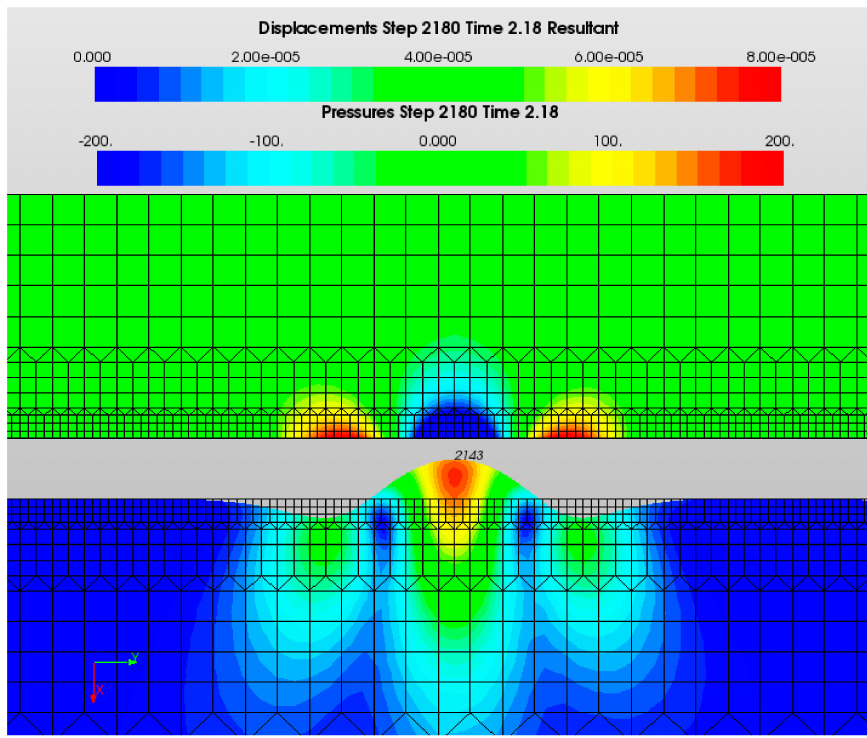
Figure 2. This display shows the region around node 2143, an element junction at 217 m radius from the model centre to the left. Results for the solid displacements are vector magnitudes, colour coded up to 80 µ m, using a similar colour display used in Figure 1, where blue shows a low value. The deformation is exaggerated for clarity. The water pressures are bi-polar to ± 200 Pa with zero deviation from normal shown as